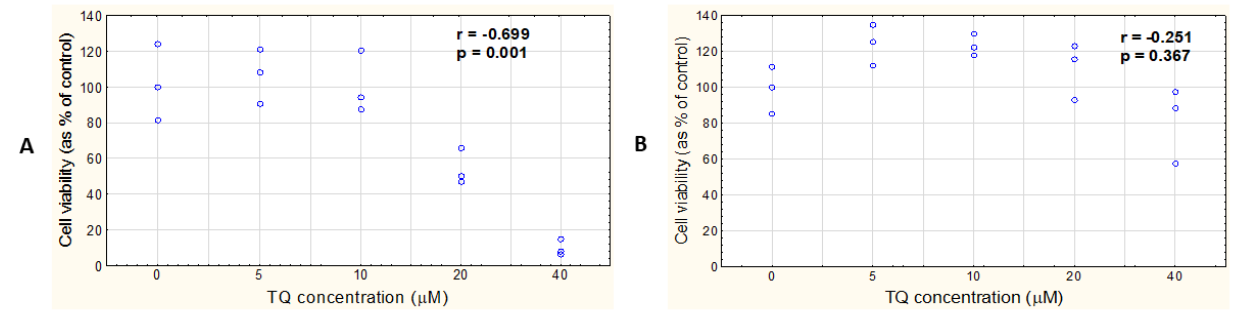
Figure 10. TQ does not inhibit proliferation of normal melanocytes. Cytotoxicity assessment (WST-1) in A375 melanoma cells ( A ) and human epidermal melanocytes (HEM) ( B ) treated with different concentrations of free TQ for 24 h. Spearman correlation analysis of the data shows the relationship between TQ concentration and cell viability. Where 0 denotes DMSO control; Spearman correlation coefficient (r) and p-value are shown; data are presented as mean ± SD; p < 0.05 was considered to be statistically significant.